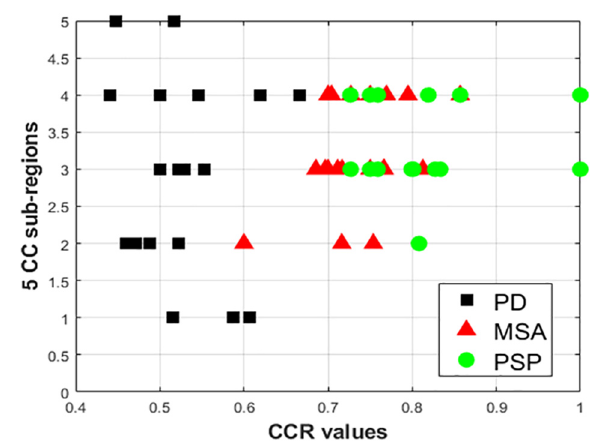
FIGURE 5 | Plot of frequency of occurrence of CC sub-regions using energy feature, based on entries in AI ( X axis represents CCR values; Y -axis represents the five distinct CC sub-regions). The vertical spread for PD-NC (black) indicates greater spread of maximum texture altered sub-regions in AI for all PD subjects, compared to MSA(red) and PSP (green) where for all subjects maximum texture alteration was mostly concentrated at mid-body (R3 and R4) for all respective